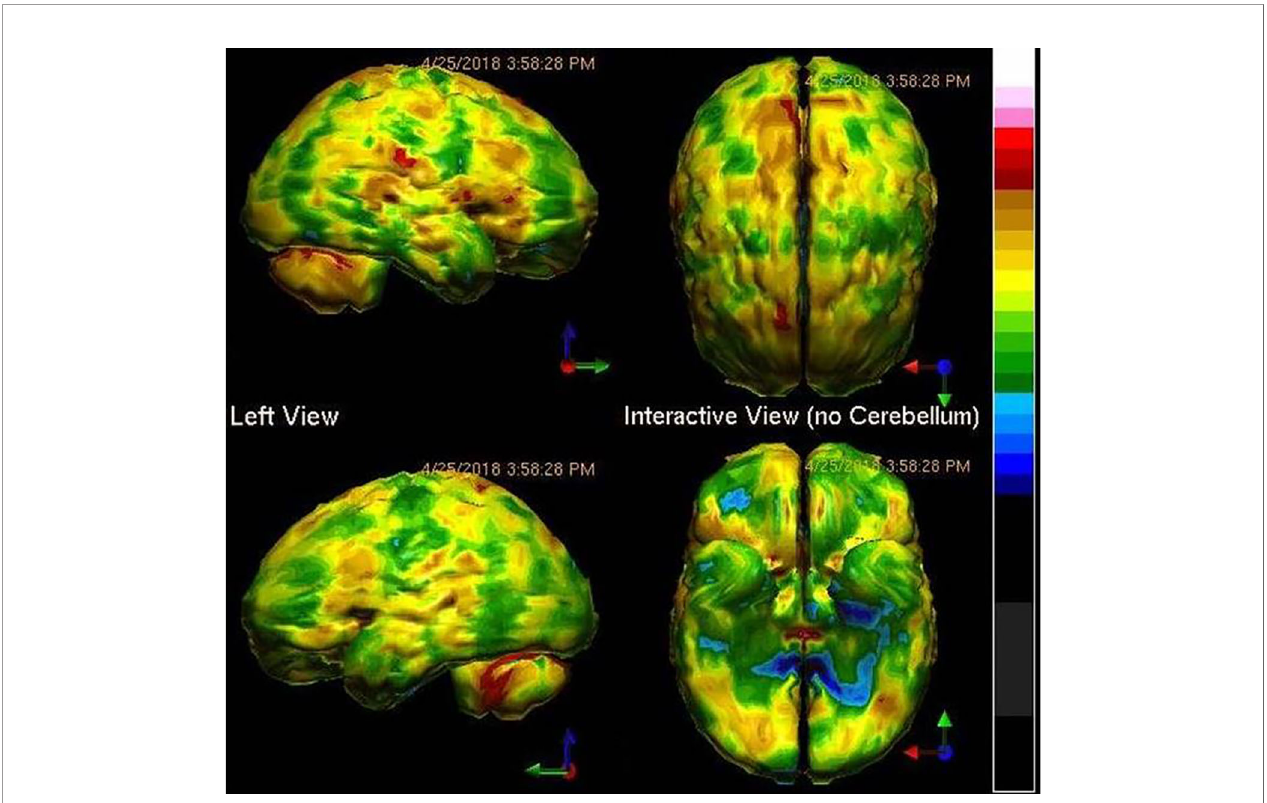
FIGURE 1 | Tc-99m-HMPAO perfusion SPECT scan data presented in surface rendering. The color scale is scaled relative to the patient's mean cerebral perfusion. Mean blood fl ow (72%) is in yellow. Color shifts occur at approximately every 0.5 SD (3%) relative to the patient's mean. Diffuse cortical hypoperfusion (green and blue) is clearly